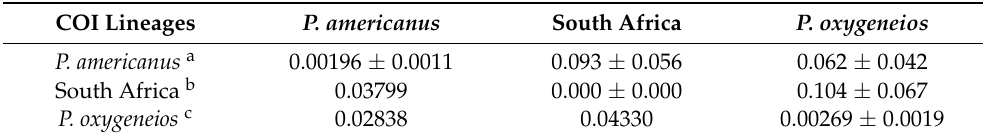
Table 3. Nucleotide diversity ( P i ± SD ) within three lineages of COI sequences (on the diagonal). Estimates of net evolutionary divergence between COI lineages ( d ± SD , above the diagonal). Average number of nucleotide substitutions per site between COI lineages ( D xy , below the diagonal).